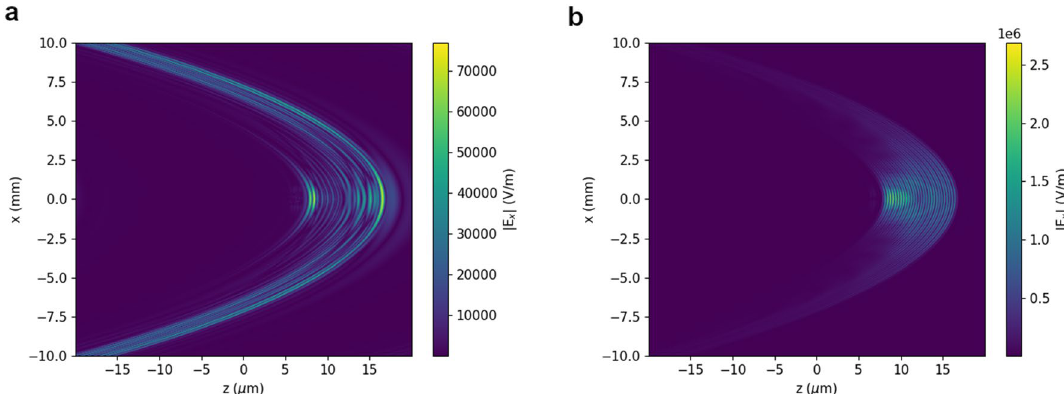
Figure 1. Electric field of undulator radiation calculated using GPT for an electron beam with 100 MeV energy, 0.1% uncorrelated energy spread, 0.1 mrad divergence, 1 π mm mrad normalized emittance and 0.1 pC charge. The r.m.s. bunch duration is ( a ) 1 fs and ( b ) 100 as. The observation point is 1 m from the undulator